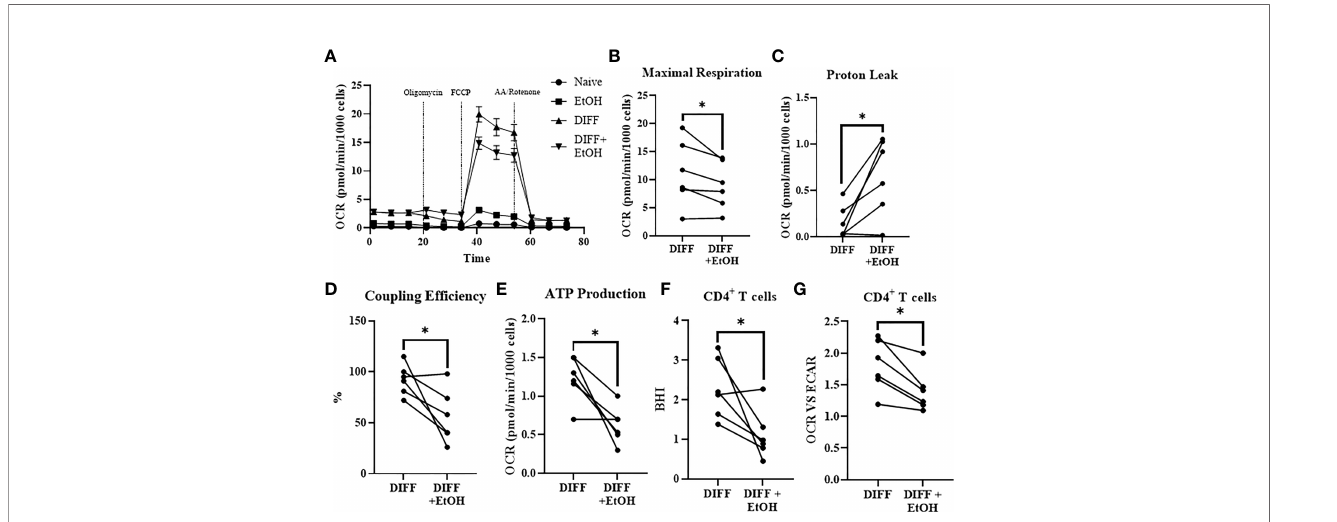
FIGURE 5 | Impact of ethanol on CD4 + T cell mitochondrial function. (A) All experimental groups were analyzed using the Mitostress test. (B) Ethanol decreased maximal respiration. (C) Ethanol increased mitochondrial proton leak. (D) Ethanol decreased coupling ef fi ciency and (E) ATP production. Ethanol decreased (F) BHI and (G) OCR/ECAR ratio in differentiated CD4 + T cells. OCR= oxygen consumption rate; FCCP, Carbonyl cyanide-p-tri fl uoromethoxyphenylhydrazone; AA, Antimycin; BHI, Bioenergetic Health Index; DIFF, differentiated and no ethanol treatment, and DIFF + EtOH, differentiated and ethanol-treated. Data represents CD4 + T cells from 6 donors with lines connecting values of same donors. Signi fi cance differences (p ≤ 0.05) were determined by paired T-tests. *p ≤